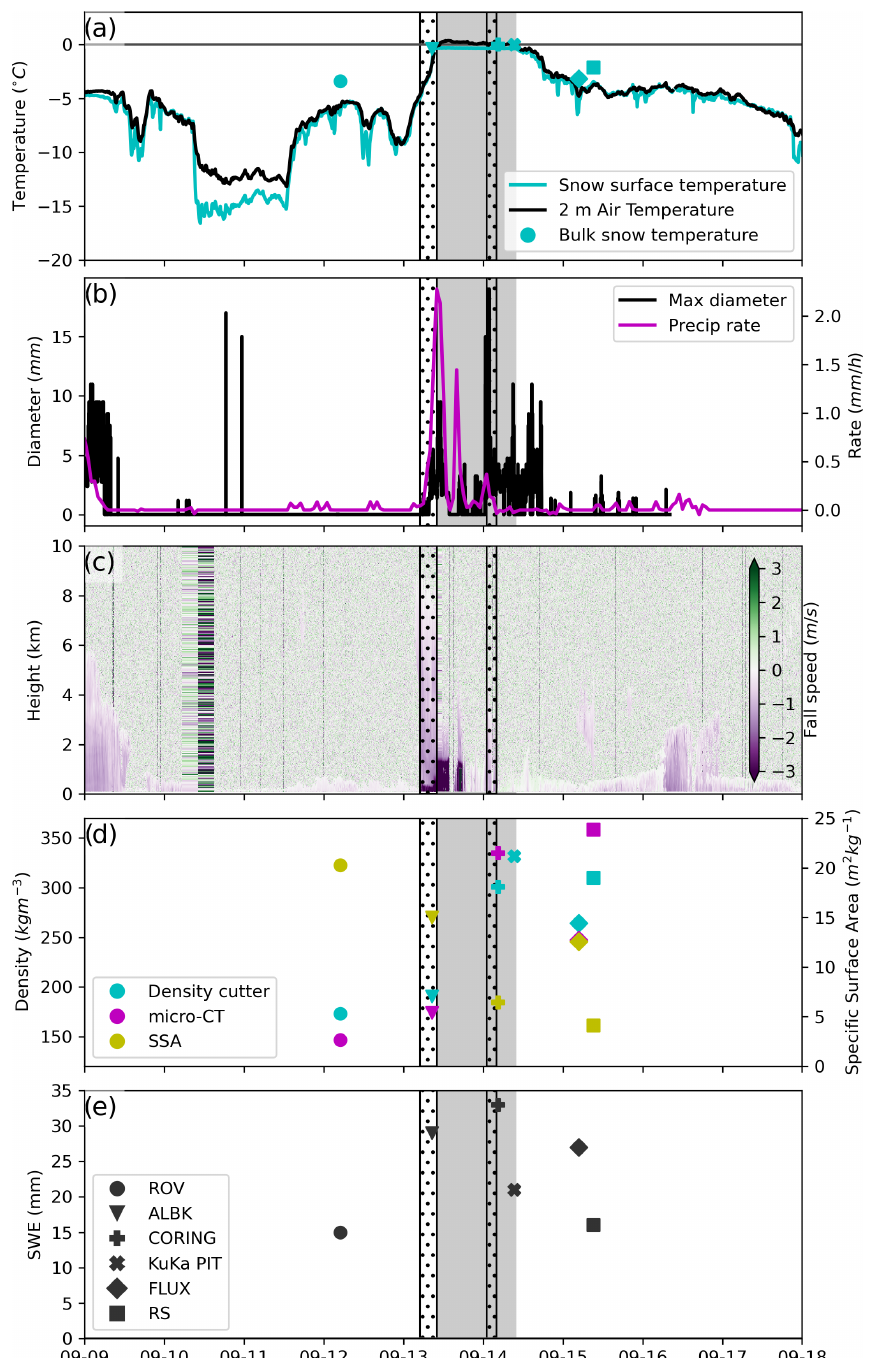
Figure 2. (a) The 2m air, skin, and bulk snow temperature; (b) precipitation rate (pluviometer) and maximum particle diameter (Parsivel); (c) KAZR mean Doppler velocity; (d) SSA and bulk snow density from both the micro-CT (snow with and without the SSL) and the density cutter; (e) SWE and snow depth. Different symbols denote the different snow pit locations. Shaded area indicates air temperatures above 0 ◦ C surrounding the two ROS events (dotted